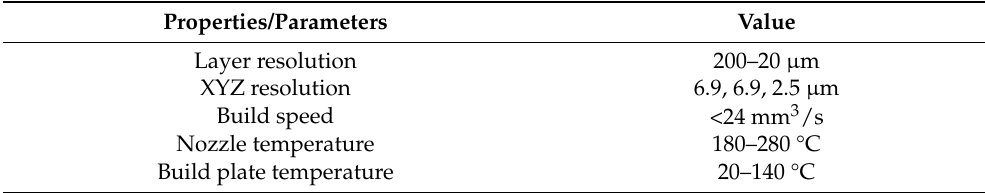
Table 2. Ultimaker™ 3 printer properties and operation parameters